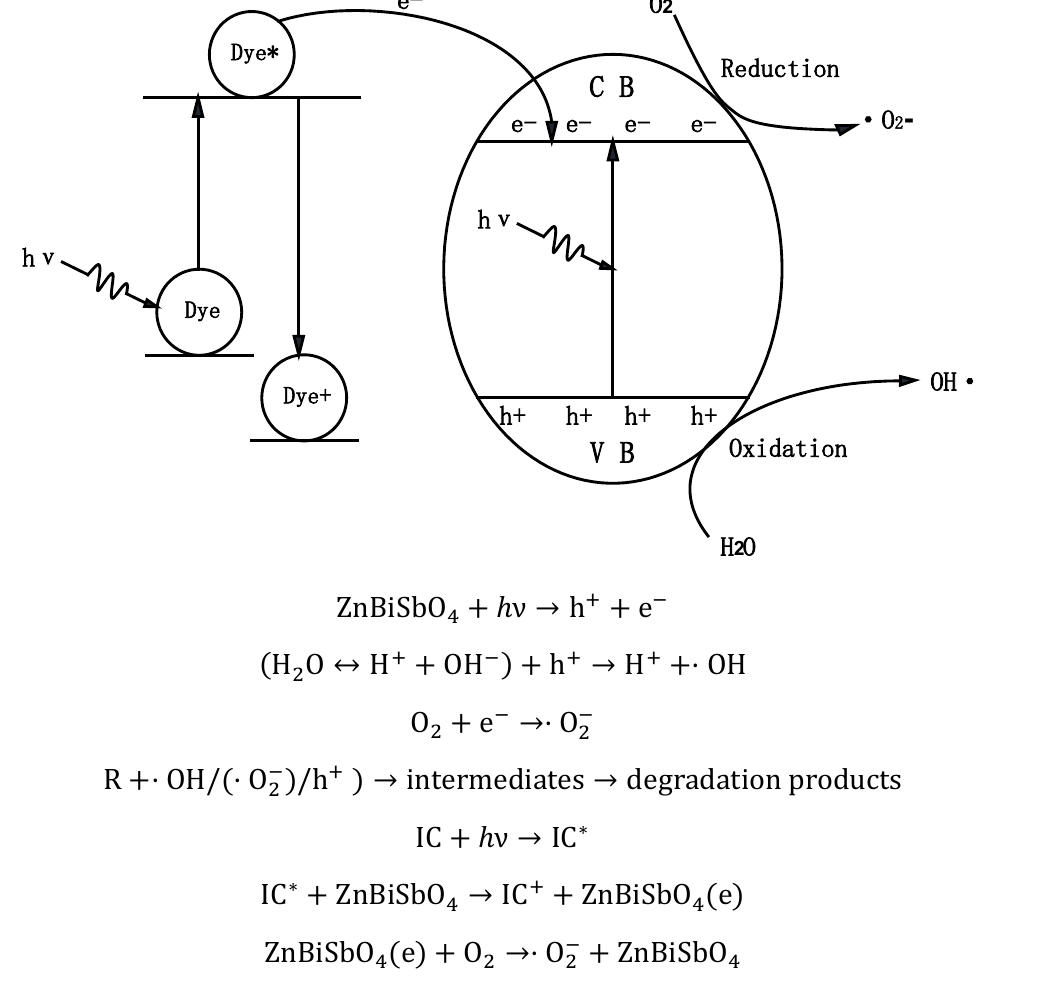
Figure 16. Suggested photodegradation reaction mechanism of IC with ZnBiSbO photocatalyst under visible light irradiation. (CB, Conduction Band; VB, Valence